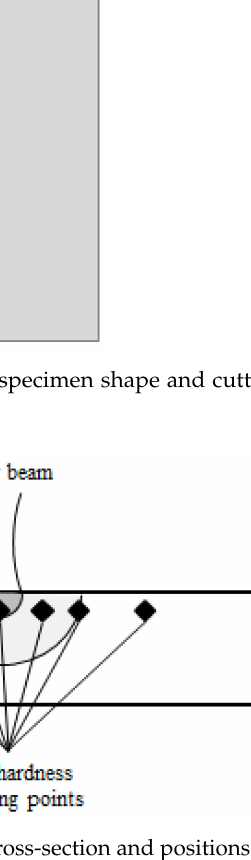
Figure 4. Schematic view of the cross-section and positions of the microhardness measuring points.